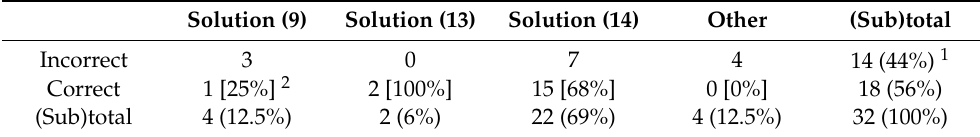
Table 1. Summary of the performance on solving Example 2 by distance